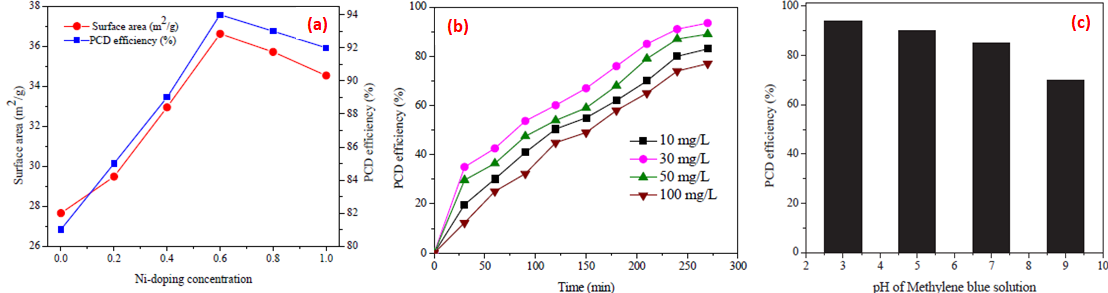
Figure 16. ( a ) Effect of surface area for photocatalytic degradation efficiency of spinel Ni x Zn 1 − x Fe 2 O 4 (x = 0.0, 0.2, 0.4, 0.6, 0.8, and 1.0) nanoparticles. ( b ) Effect of catalyst amount on the photocatalytic degradation (PCD) efficiency of spinel Ni 0.6 Zn 0.4 Fe 2 O 4 nanoparticles. ( c ) Effect of pH on photodegradation of methylene blue using catalyst Ni 0.6 Zn 0.4 Fe 2 O 4 [144]. Republished with permission from Elsevier.